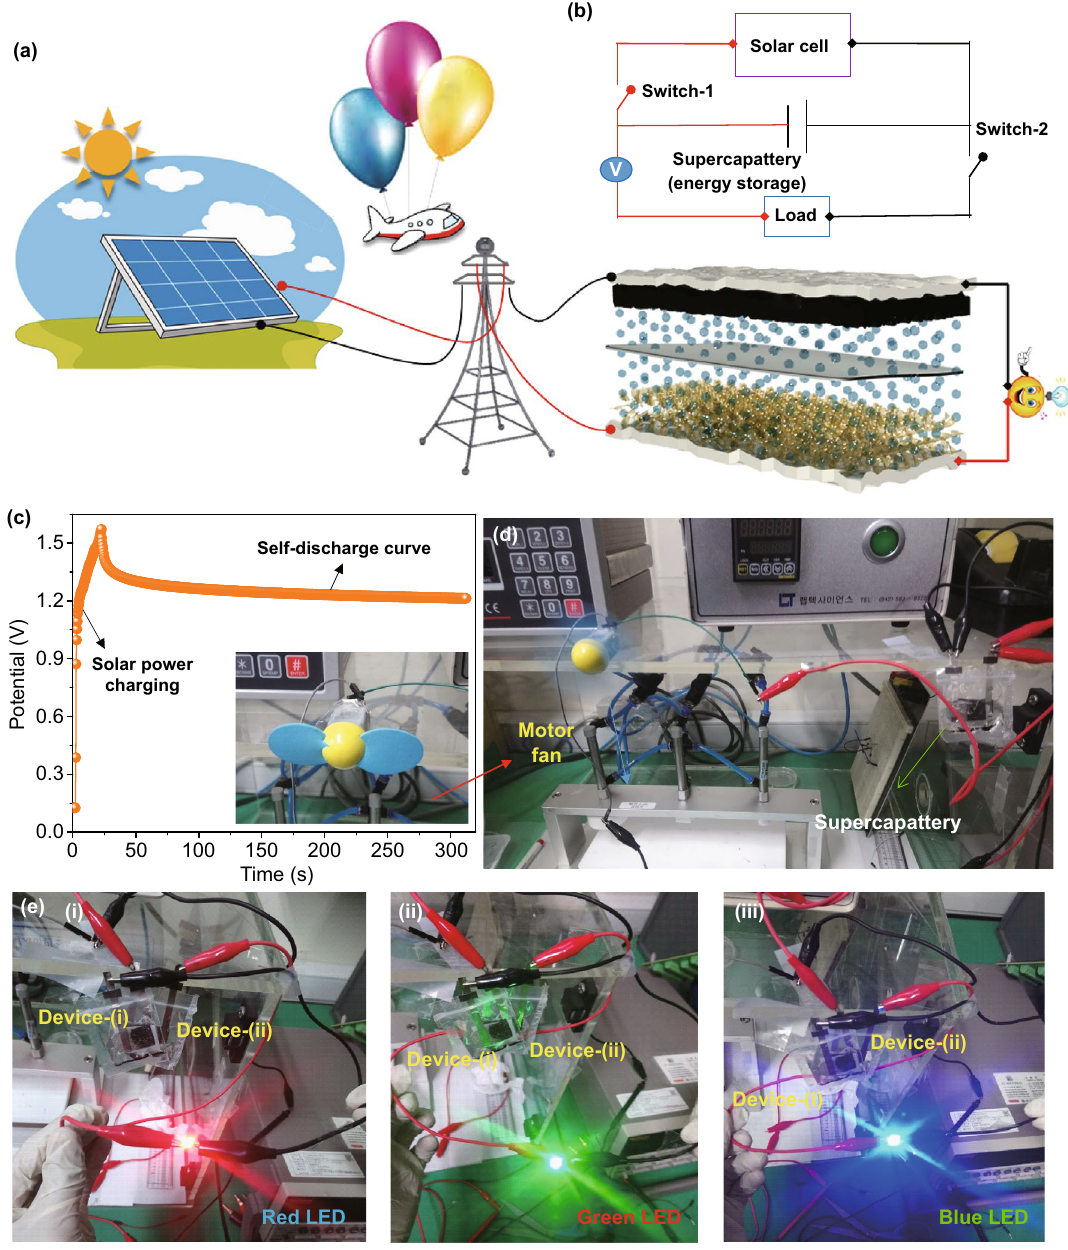
Fig. 7 a Schematic illustration of the self-powered charging station with integrated solar energy driven supercapttery devices. b Circuit diagram and c charging and self-discharge curves of solar energy-based supercapttery. d Working condition of a motor fan and e powering of various colored LEDs with solar energy-assisted